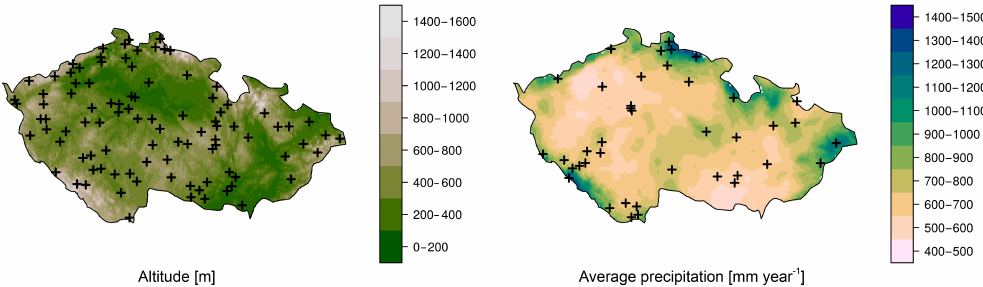
Figure 1. The study area with altitudes and locations of 96 stations used for derivation of the R factor map (left panel) and mean annual precipitation together with locations of additional stations used for uncertainty assessment (right